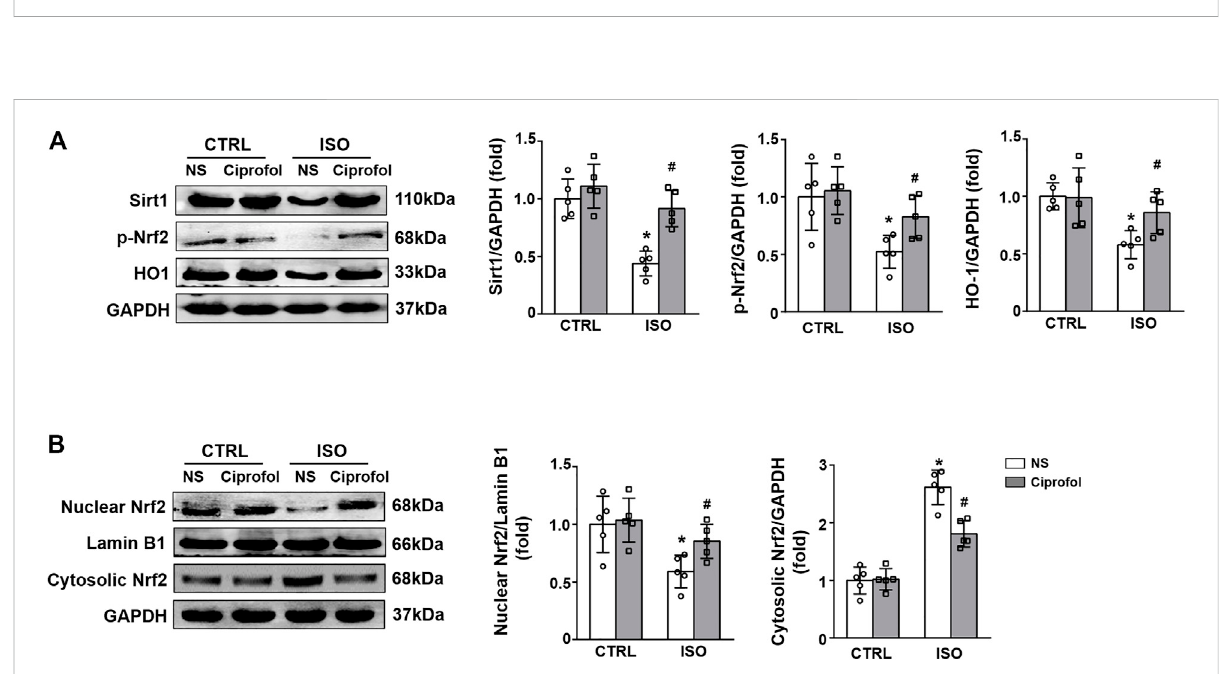
FIGURE 5 Ciprofol treatment activated the Sirt1/Nrf2 signaling pathway. (A) Western blotting analysis of Sirt1, p-Nrf2 and HO-1 in the hearts ( n = 5). (B) Western blotting analysis of nuclear Nrf2 and cytosolic Nrf2 in the hearts ( n = 5). p p < 0.05 compared to the CTRL group. # p < 0.05 compared to the ISO